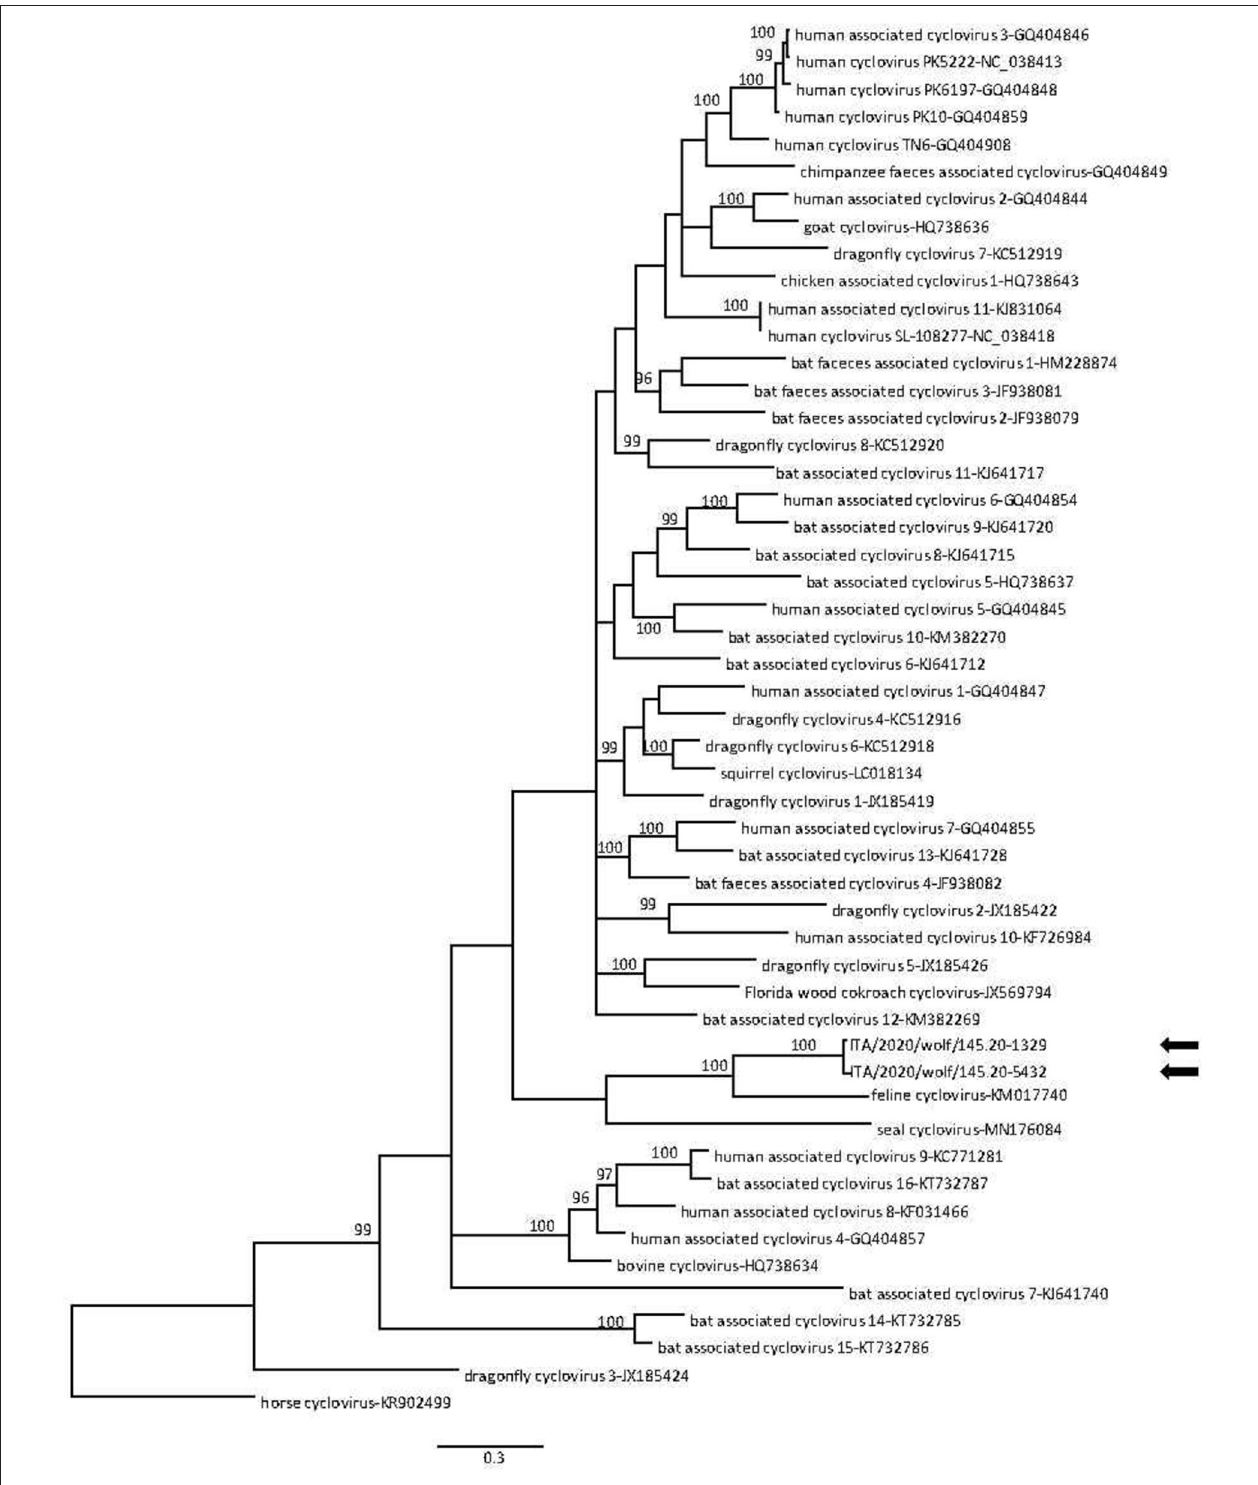
FIGURE 3 | Phylogenetic tree based on alignment of the partial replicase gene (373 nt) of canine cyclovirus isolates detected in this study and other cycloviruses retrieved from the GenBank database. Horse cyclovirus (GenBank accession no. KR902499) was used as outgroup. Posterior output of the tree was derived from Bayesian inference using 4 chains run for > 1 million generations, 2-character states (Hasegawa–Kishino–Yano) model, a proportion of invariable sites and a subsampling frequency of 1,000. Posterior probability values > 95 are indicated on the tree nodes. The black arrows indicate the sequences identified in this study. Scale bar indicates nucleotide substitutions per